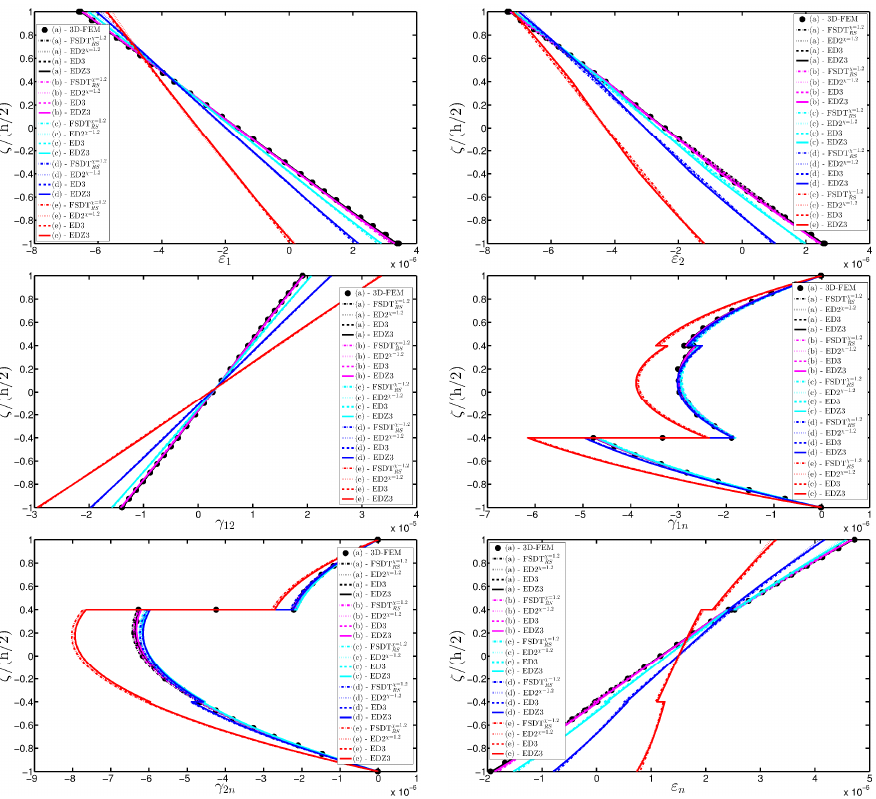
Figure 14. Through-the-thickness profiles of strain components for the CCCC laminated square plate with ( − 45/0/45 ) as stacking sequence computed at the point A for different HSDTs. The effect of the damage is investigated by varying the parameters of the function Gau-4.